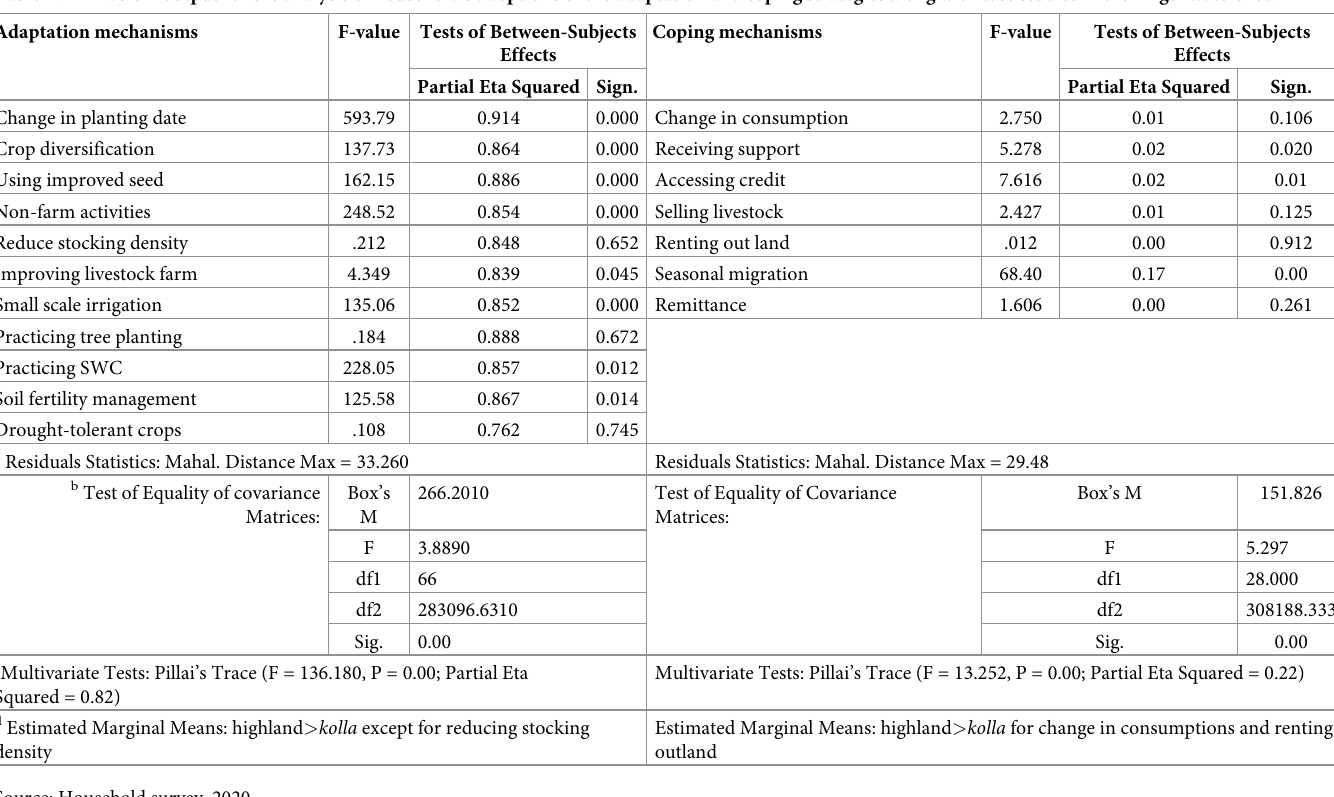
Table 2. MANOVA output for the analysis of household’s adoptions of the adaptation and coping strategies along with case studies in the Anger watershed. Adaptation mechanisms F-value Tests of Between-Subjects Coping mechanisms F-value Tests of Between-Subjects Effects Effects Partial Eta Squared Sign. Partial Eta Squared